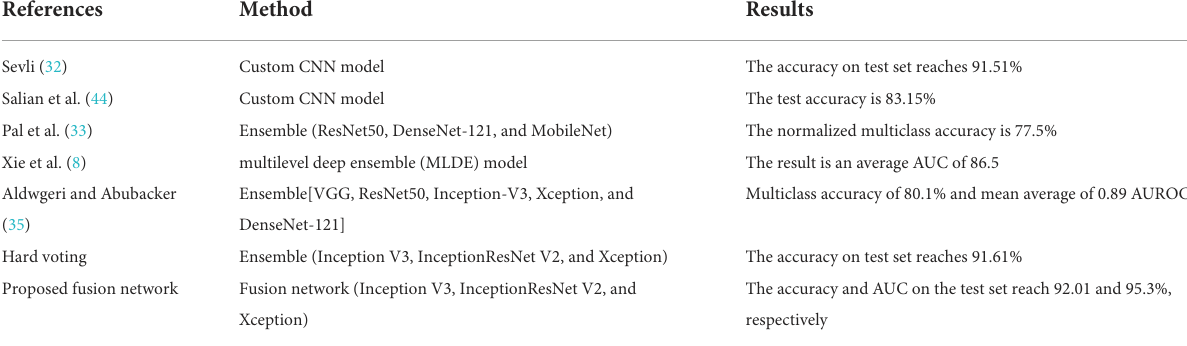
TABLE 8 Comparison of the results obtained in this study with those in the literature.